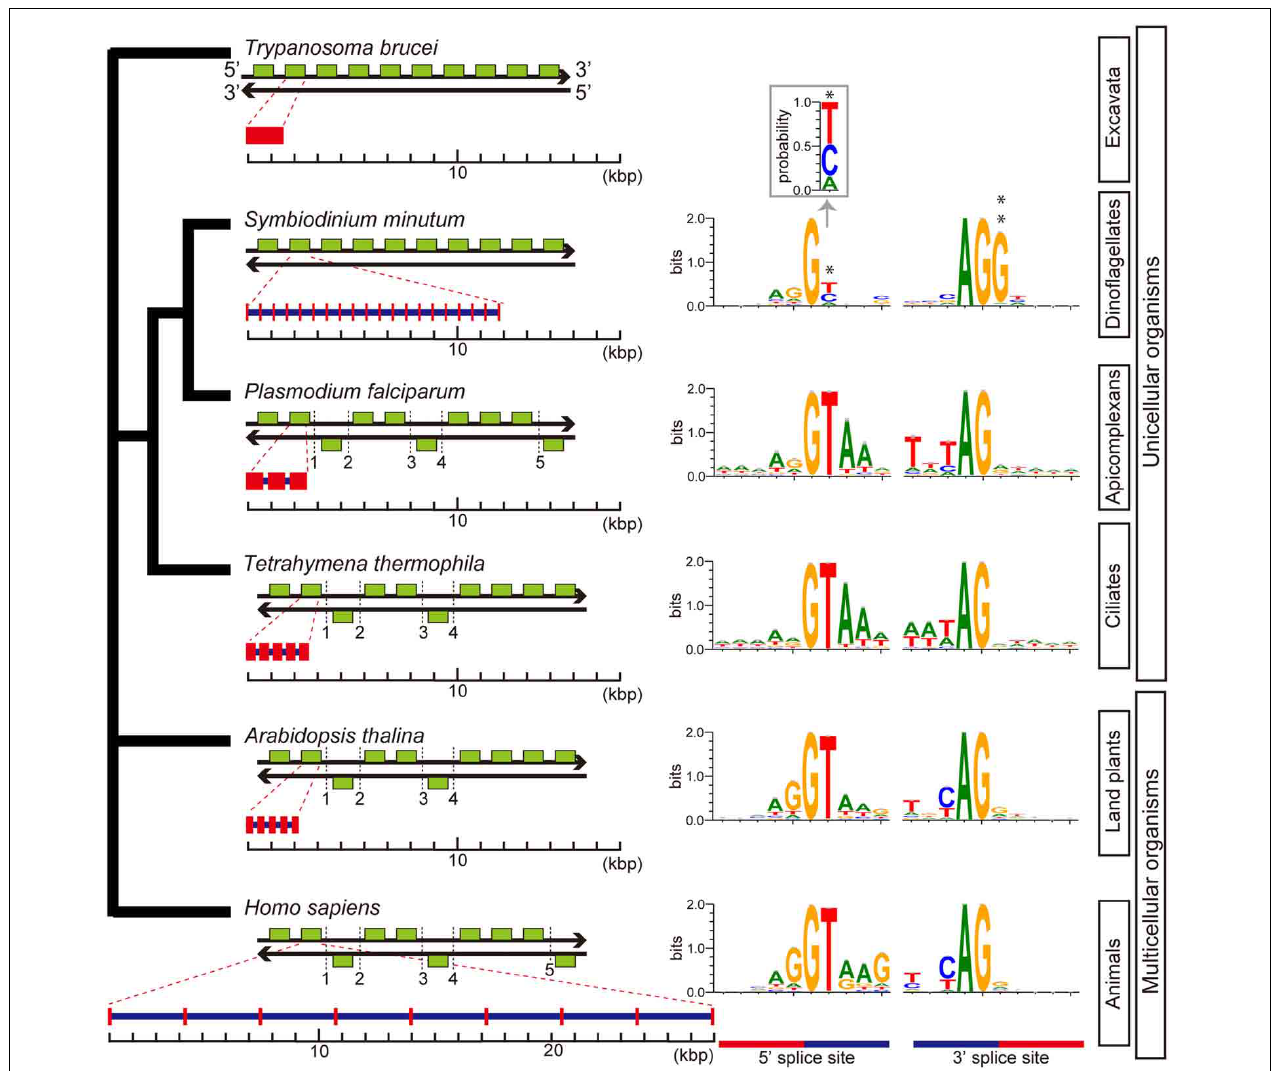
FIGURE 10 | Architecture of genes and splice site motifs in the nuclear genomes of representative eukaryotes and alveolates. Green boxes indicate typical patterns of 10-gene arrangements with the number of strand switch regions (SSRs), although the SSRs shown here are not always typical. Patterns are based on the analyses shown in Figure 6 . Gene architecture shows average gene lengths (exons in red and introns in blue) with the average intron number per gene. The sequence motif of the splice site is illustrated using WebLogo. Only two genes with spliceosomal